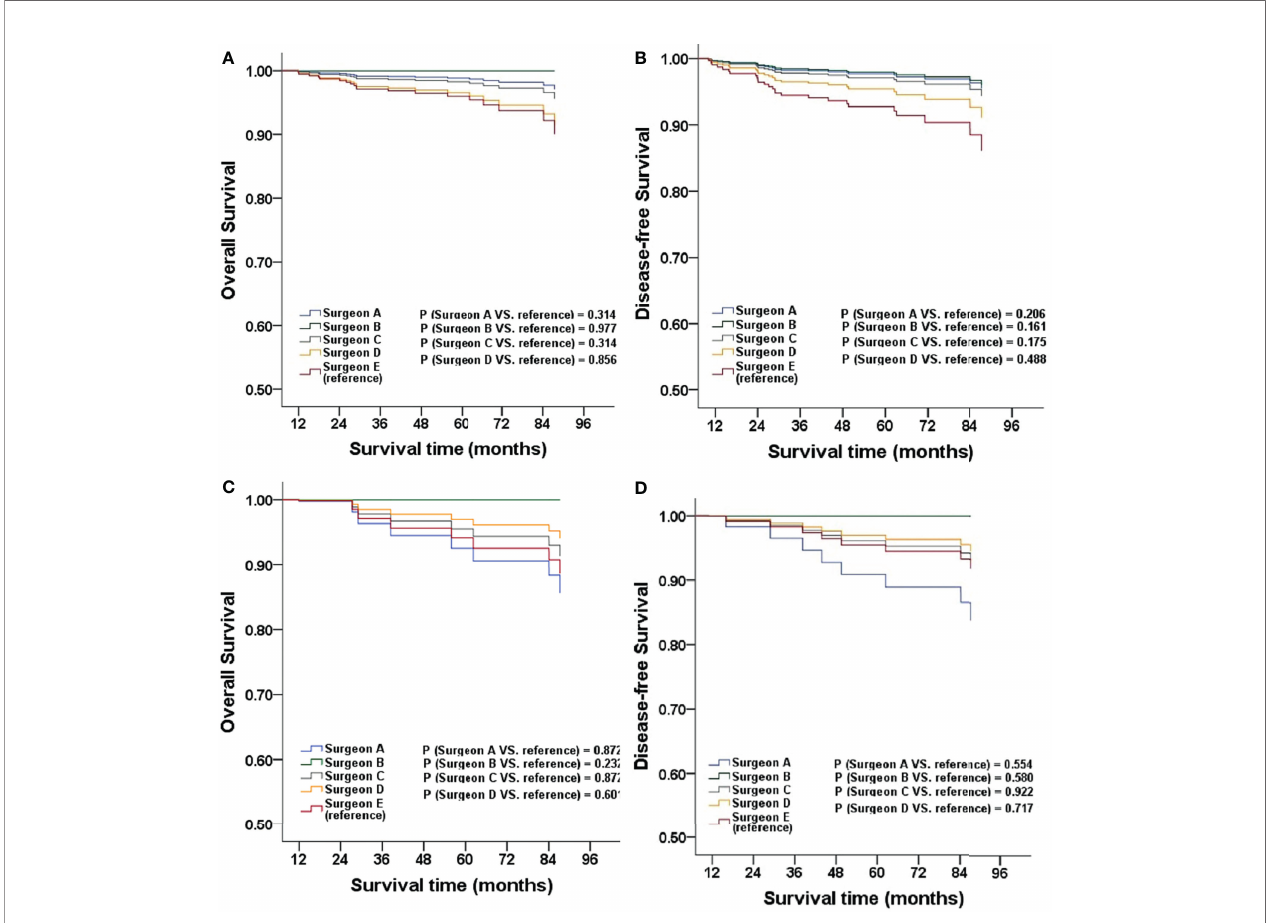
FIGURE 3 | The OS and DFS adjusted for clinicopathological factors for patients strati fi ed by surgeon (A, B) , patients strati fi ed by surgeon in MIS phase one (C, D)